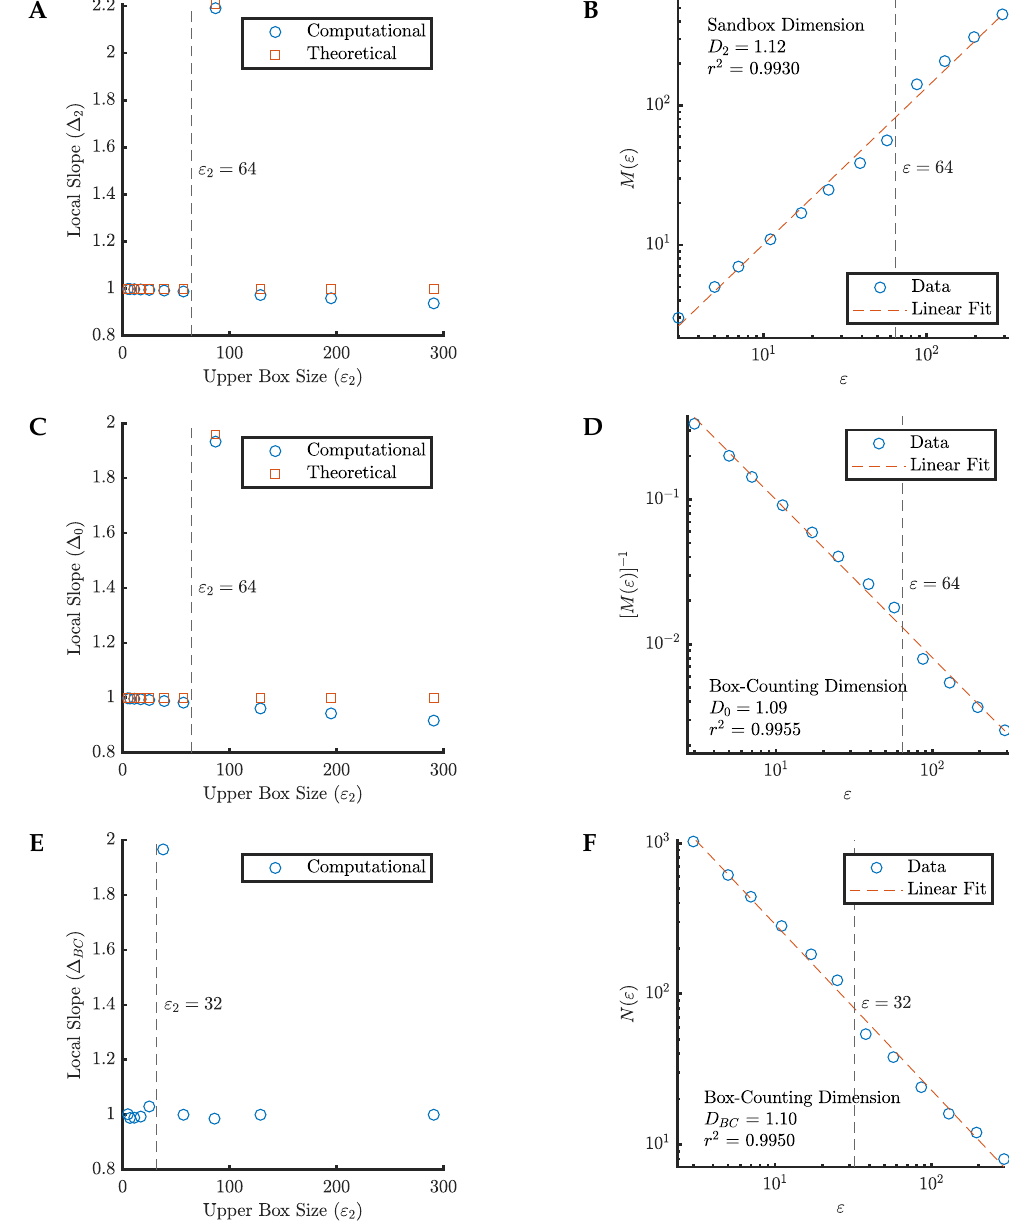
Figure 5. Estimation of the fractal dimension of the image of three non-uniformly spaced line segments in Figure 4A using the generalized sandbox ( D 2 and D 0 ) and box-counting methods ( D BC ). ( A ) Local slopes ( ∆ 2 ) between ε 1 and ε 2 , plotted as a function of the upper box size ε 2 . We compare the experimental result with the theoretical result from Equation (6). ( B ) M ( ε ) vs. ε , with the line of best fit giving D 2 = 1.12. ( C ) Local slopes ( ∆ 0 ), comparing the experimental result with the theoretical result from Equation (7). ( D ) M − 1 ( ε ) vs. ε , with the line of best fit giving D 0 = 1.09. ( E ) Local slopes ( ∆ BC ) computed using the box-counting method. ( F ) N ( ε ) vs. ε , with the line of best fit giving D BC =